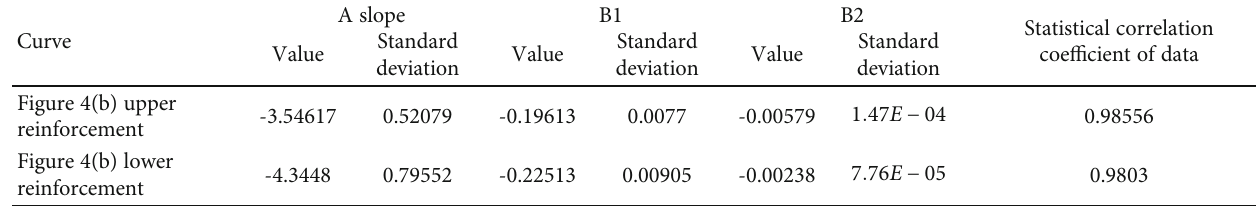
Table 5: According to the fi tted parameters of Figure 4(b).